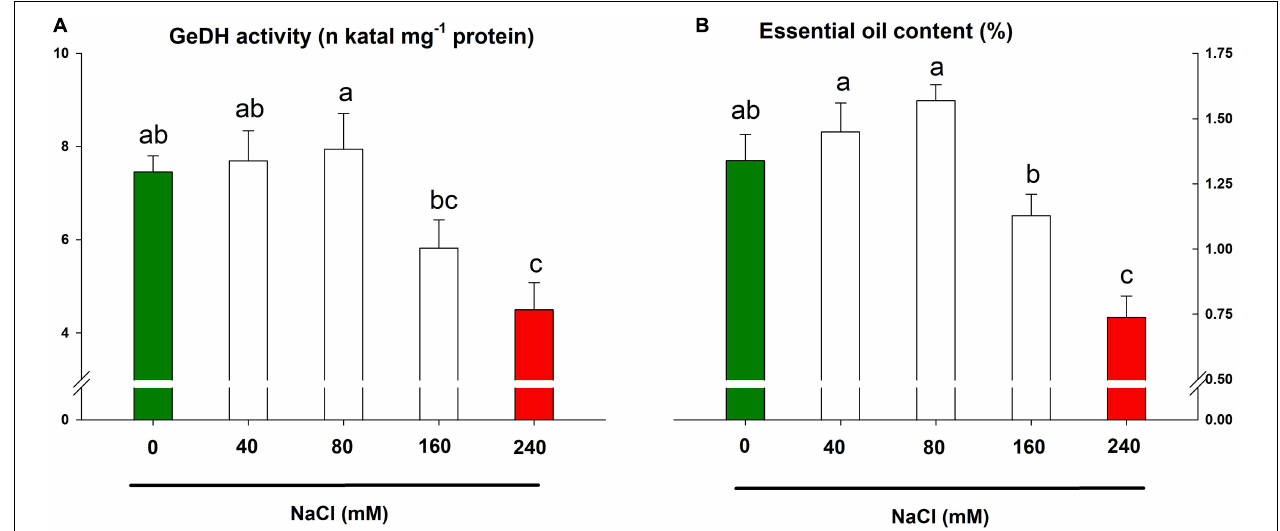
FIGURE 8 | Lemongrass essential oil machinery under salinity stress. The impact of different salt concentrations (0, 40, 80, 160, and 240 mM) was observed on geraniol dehydrogenase (GeDH) activity (A) and essential oil content (B) of lemongrass plants. Each bar represents mean ± SE ( n = 3). Means followed by the same letter(s) do not differ by LSD test at 5% probability level ( α = 0.05). The colors are just visual ques for readers to quickly distinguish between control and most stressed treatment.